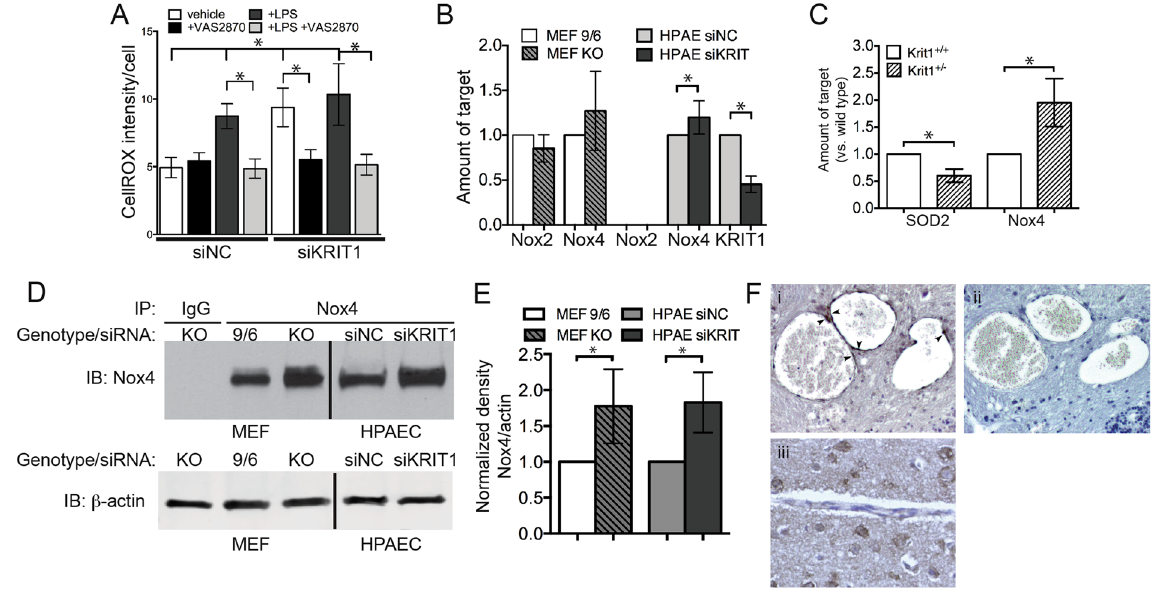
Figure 3. Loss of KRIT1 increases production of ROS via up-regulation of Nox4. ( A ) CellROX ® Green fluorescence in negative control (NC) and KRIT1 siRNA transfected HPAEC treated with the Nox inhibitor VAS2870, + / − 1 µ g/mL LPS. Data are mean + / − SEM, p < 0.001 by ANOVA; * p < 0.05 using Dunn’s post- hoc test, n = 11. ( B ) Relative mRNA expression in KO and reconstituted (9/6) MEF, and NC or KRIT1 siRNA transfected HPAEC. Data are mean + / − SEM, n = 6. Nox2 levels were undetectable in HPAEC. p < 0.001 by ANOVA; * p < 0.05 by Tukey’s post-hoc test. ( C ) Relative mRNA expression in wild type (Krit1 + / + ) and KRIT1 heterozygous (Krit1 + / − ) mouse lung tissue. p < 0.001 by ANOVA; * p < 0.01 by Tukey’s post-hoc test, n = 6. ( D ) Nox4 protein expression in KO and 9/6 MEF, and in NC and KRIT1 siRNA transfected HPAEC. Nox4 was immunoprecipitated from 500 µ g total cell protein for each condition. Whole cell lysate was probed for beta-actin as loading control. Representative blot was cropped for space considerations; vertical line indicates intervening lanes removed, n = 4. ( E ) Densitometry analysis of ( D ). Expression of Nox4 normalized to loading control beta-actin, p < 0.001 by ANOVA; * p < 0.05 by Tukey’s post-hoc test. ( F ) Nox4 expression in CCM-like lesions of Krit1 ECKO mice. (i) Nox4 staining (dark brown, arrowheads) lines the cavernous lesions of a CCM- like lesion in the midbrain; (ii) Serial section of the same lesion as in (i), stained with rabbit IgG as a negative control; (iii) Normal vessel in cerebellum of Krit1 flox/ + mouse (Krit1 + / − ). Images are representative, n = 6 mice/